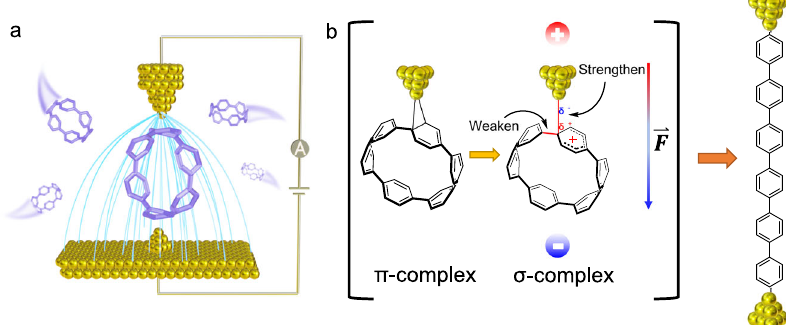
Fig. 1 | Schematic representation of OEEF catalysis of EAS reactions. a Schematic of single-[6]CPP junction. b The proposed mechanism of the OEEF-catalyzed EAS reaction which proceeds via a transition from π -complex to charge-separated σ -complex intermediate.